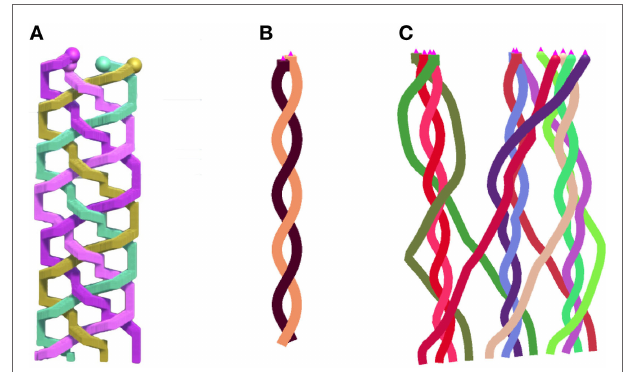
FigUre 11 | (a) Three threads are braided from the bottom upwards. Similar to a loom, one program concerts the exact paths (von Mammen et al. 2016a). (B) Two swarm grammar agents (pink pyramids at the top) see each other and make sure to cross each other’s path in order to yield braided traces. (c) Twelve swarm grammar agents braiding together. As the parameter values are not properly adjusted yet, wider streaks seemingly occur at